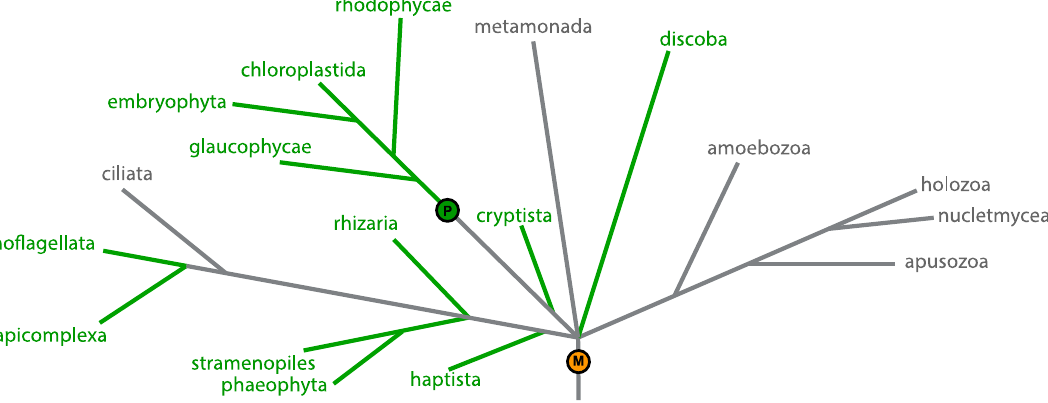
Figure 1. The diversity of eukaryotes, with lineages containing plastids identified in green. The origin of the cyanobacterial plastid present in the majority of photosynthetic organisms (excluding Paulinella spp., which has a plastid derived from a second primary endosymbiosis) and the origin of the alphaproteobacterial mitochondria are indicated by the green P and orange M, respectively.